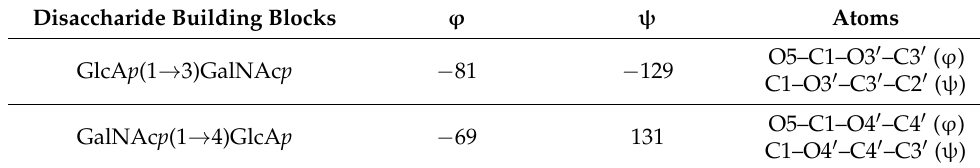
Table 4. Average torsion across the 1 → 3 and 1 → 4 inter-glycosidic bonds used in CVLS. Disaccharide Building